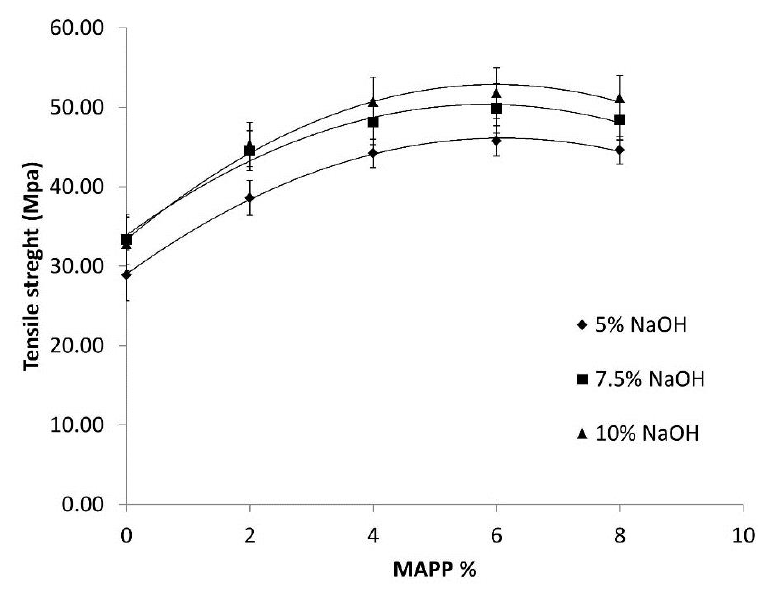
Figure 3. Evolution of the tensile strength of the composites against the coupling-agent contents.